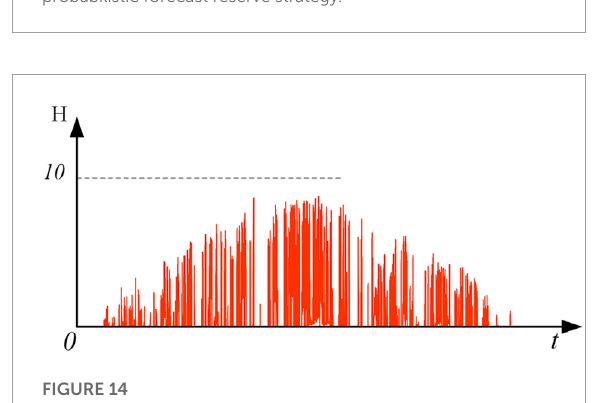
FIGURE 14 Value of virtual inertia in the PV using AFB-VIC.